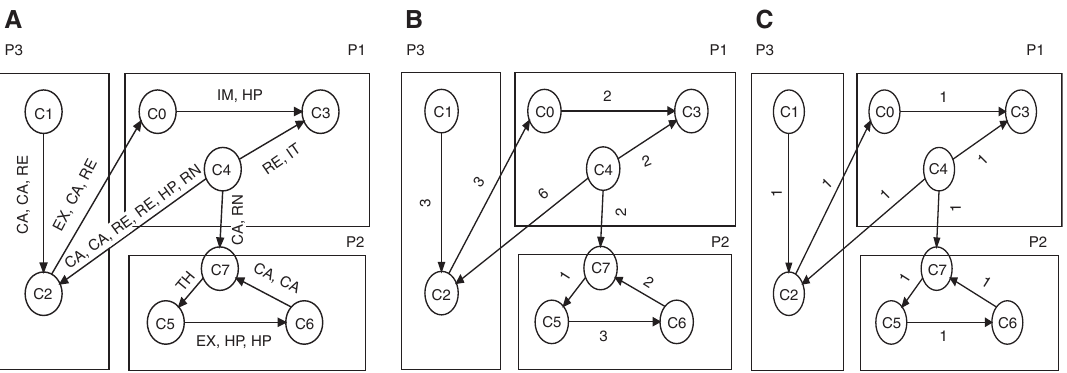
Figure 2: Weighted and Unweighted Version of a Hypothetical Object-Oriented Software